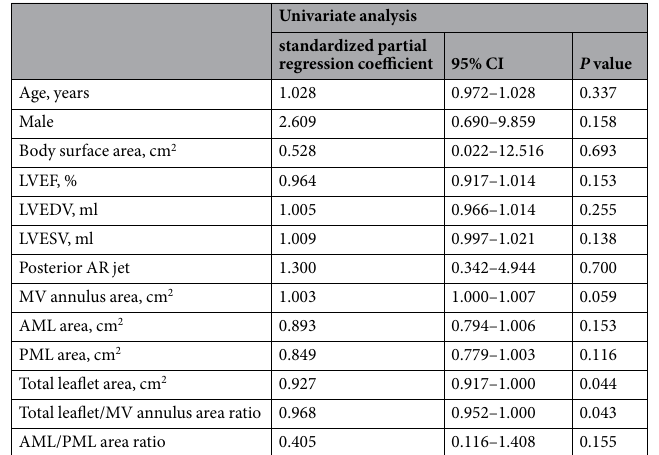
Table 6. Univariable analysis of significant mitral regurgitation. CI, confidence interval; LVEDV, left ventricular end-diastolic volume; LVESV, left ventricular end-systolic volume; AR, aortic regurgitation.; MV, mitral valve; AML, anterior mitral leaflet; PML, posterior mitral